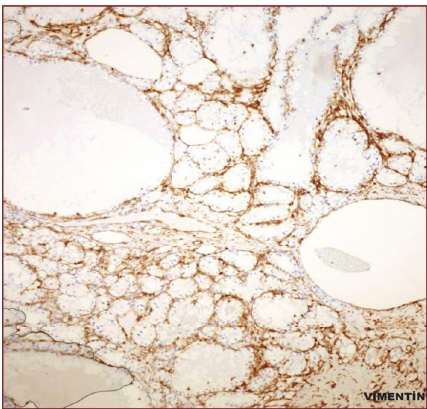
Figure 3: Clear cells, positively stained by Vimentin ( × 40).